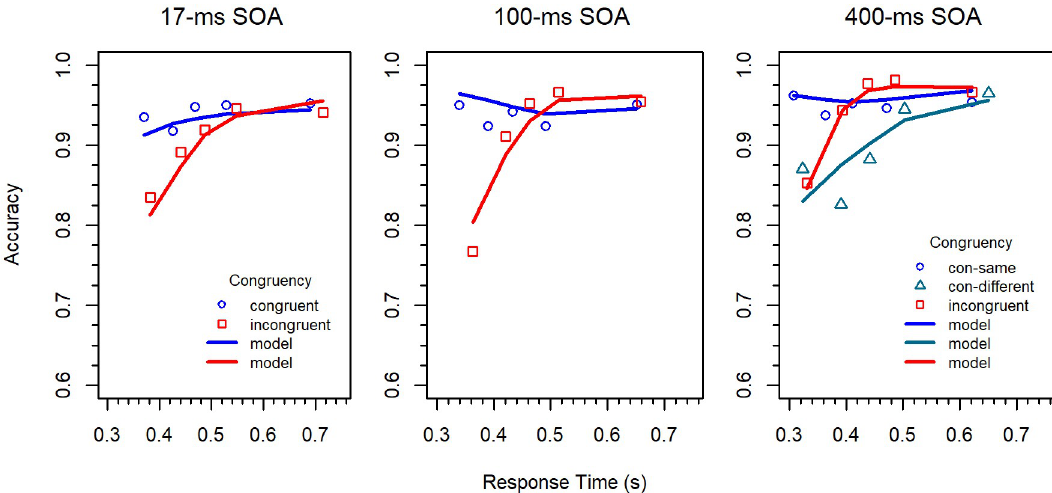
Fig 7. CAFs for the different conditions in Experiment 2 (data points). The lines represent the fit of the DMC